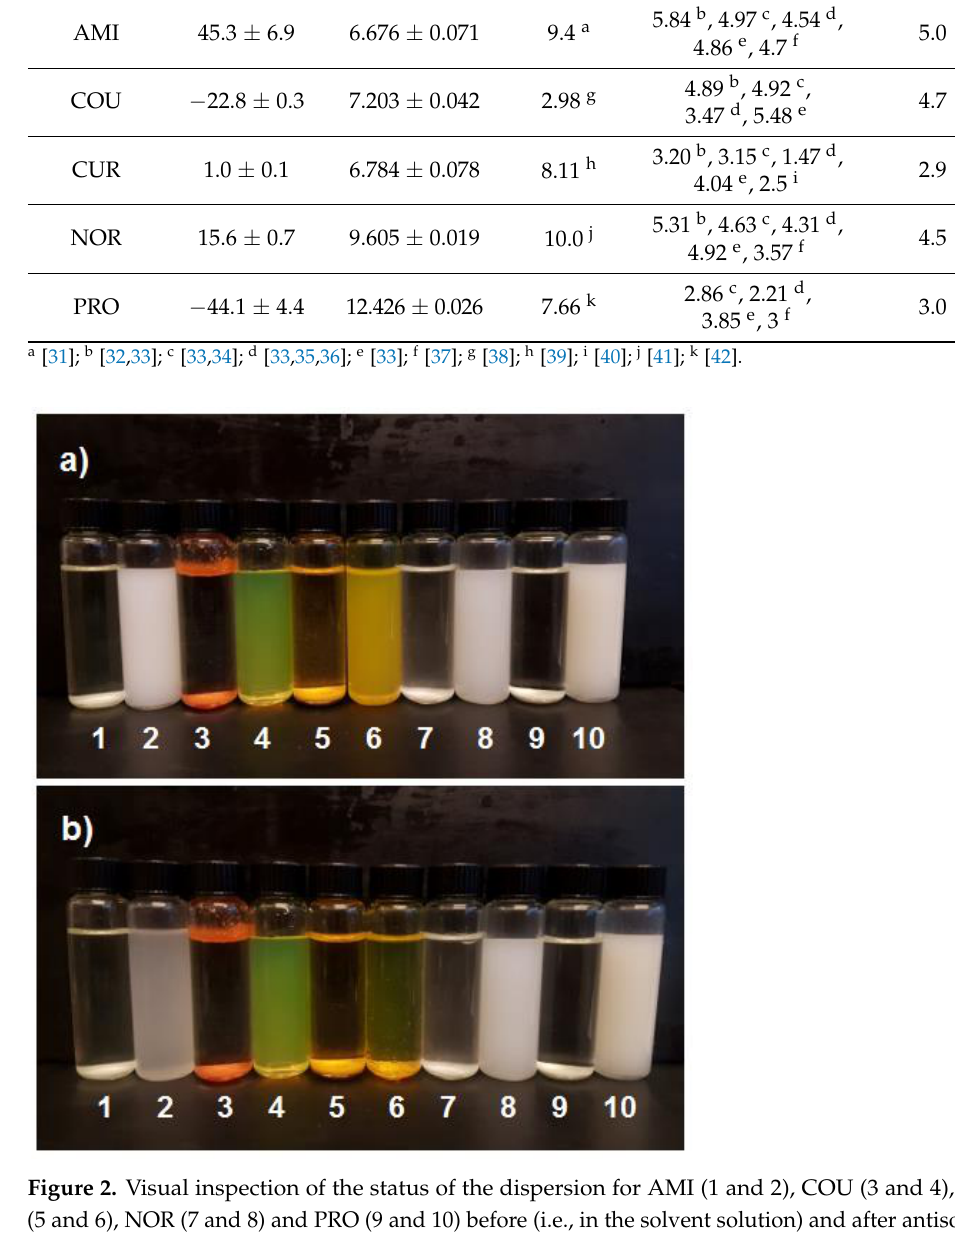
Table 3. The results of the zeta potential and pH measurements of the re-dispersions (in antisolvent) of the particles of the end dispersions of protocol No. 1 together with the values of 𝑝𝐾 𝑎 , log𝑃 and (log𝑃) 𝑎𝑣 of the compounds.